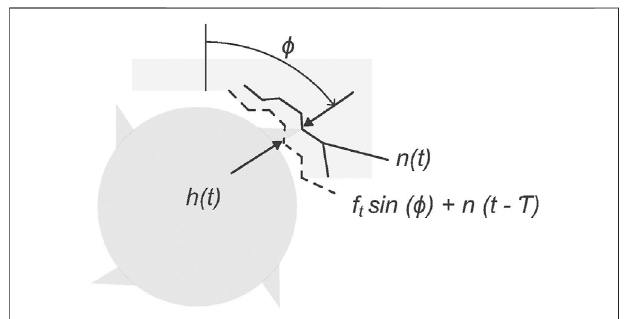
FIGURE2| Workpiecegeometryproducedbythesimulationmodel. h ( t ) is the instantaneous depth of cut at time t that is the distance between the currentnormaldirectionvibrationlevelatangle ϕ andthecutsurfaceatangle ϕ produced at time t − T , where T is the time period of cutting tool revolution between two neighbouring cutting